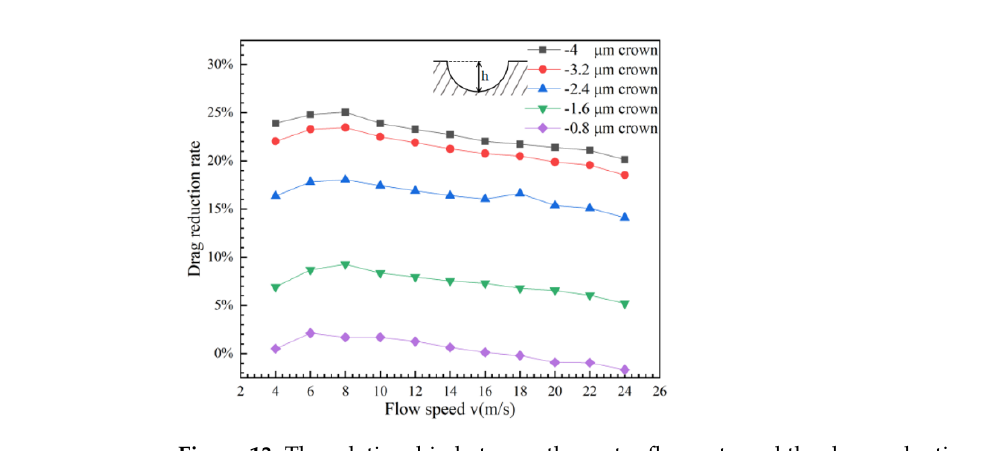
Figure 15. The contour of pressure ( a ) at the depth of − 4 μ m ( b ) at the depth of − 1.6 μ m. 4. Conclusions In this paper, the flow characteristics of water in different V-shaped groove surface structures with the spherical crown microstructure was investigated. The effect of differ- ent spherical crown structures on drag reduction rates was analyzed by comparing the surface Reynolds shear stress, fluid velocity, near-wall turbulent kinetic energy and the distribution of intensity of vortexes. it leads to the following conclusions: (1). Both the positive and negative protrusions of the spherical crown structure con- tribute similarly to reducing surface resistance, but there are also some differences. Two kinds of protrusions have a higher drag reduction effect for the flowing liquid with a low